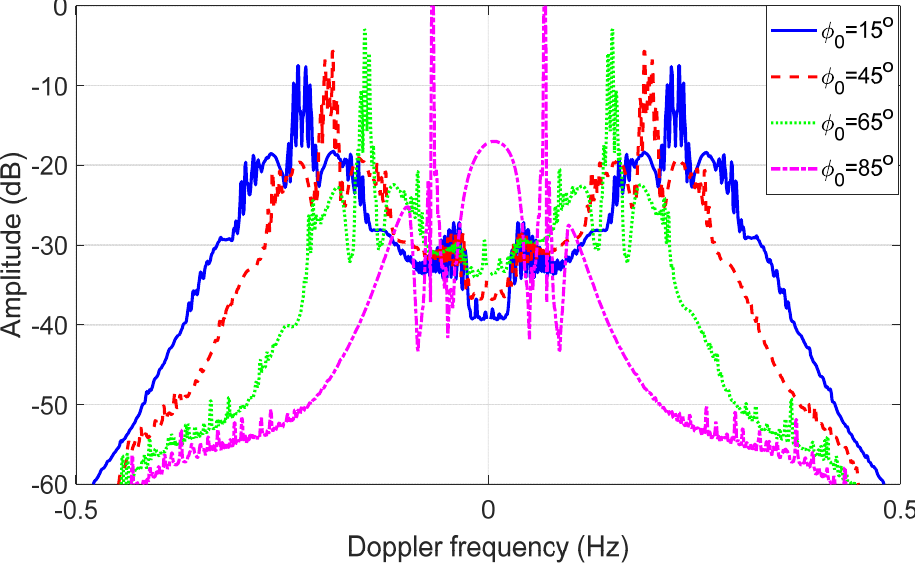
Figure 11. Simulated total RCSs containing first- and second-order RCSs for different bistatic angles.